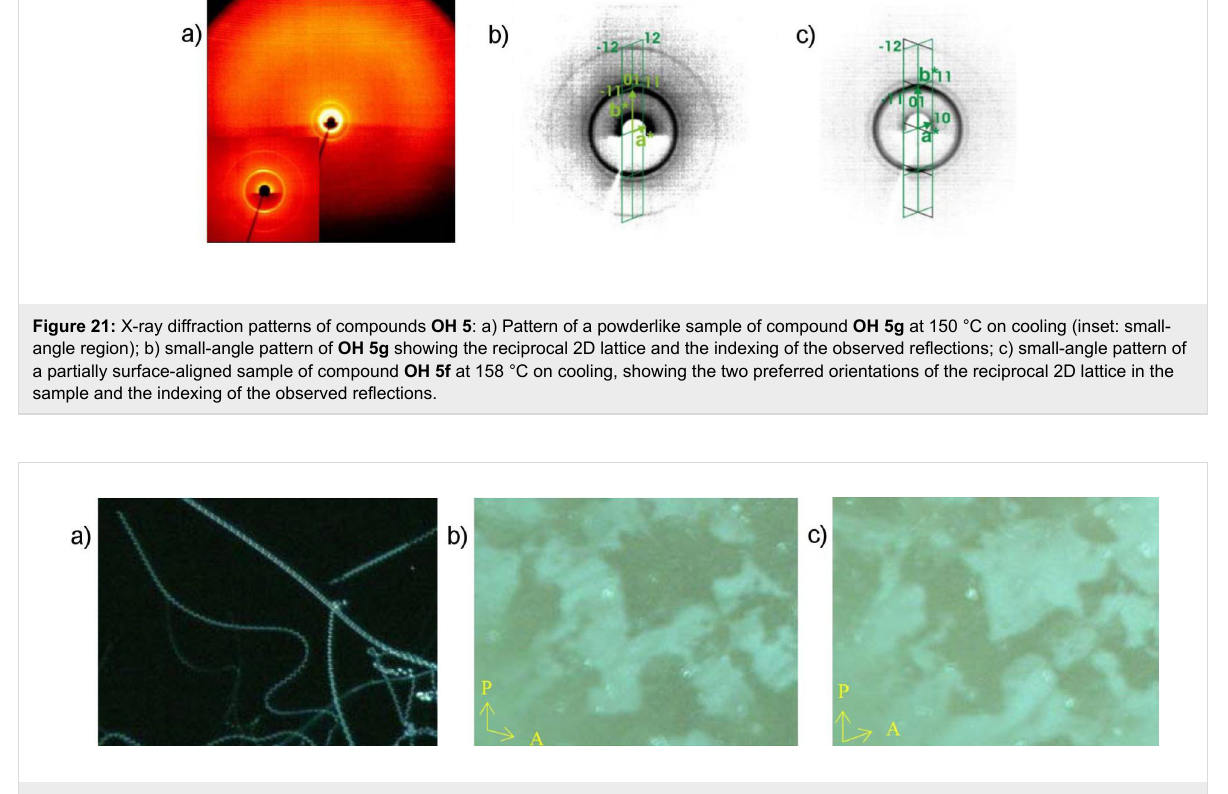
Figure 22: Photomicrographs of compound OH 5f : a) Appearance of spiral filaments on slow cooling of the isotropic liquid at 171 °C; b), c) cooling from the isotropic phase in the presence of an electric field of 15 V/ μ m results in a texture with chiral domains, which are visible by rotation of one polariser clockwise or anticlockwise by several degrees from the crossed position; T = 165 °C.